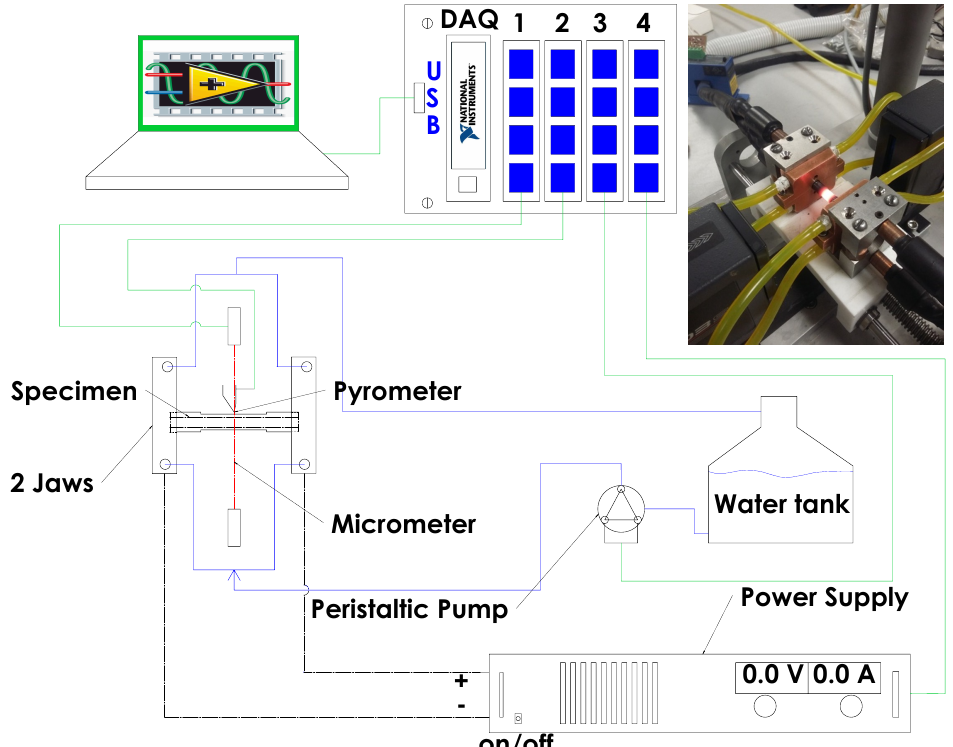
Figure 2. Schematic of the experimetal device employed to measure the oxide